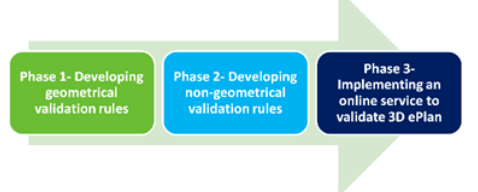
Figure 5. defined phases in 3D data validation investigation